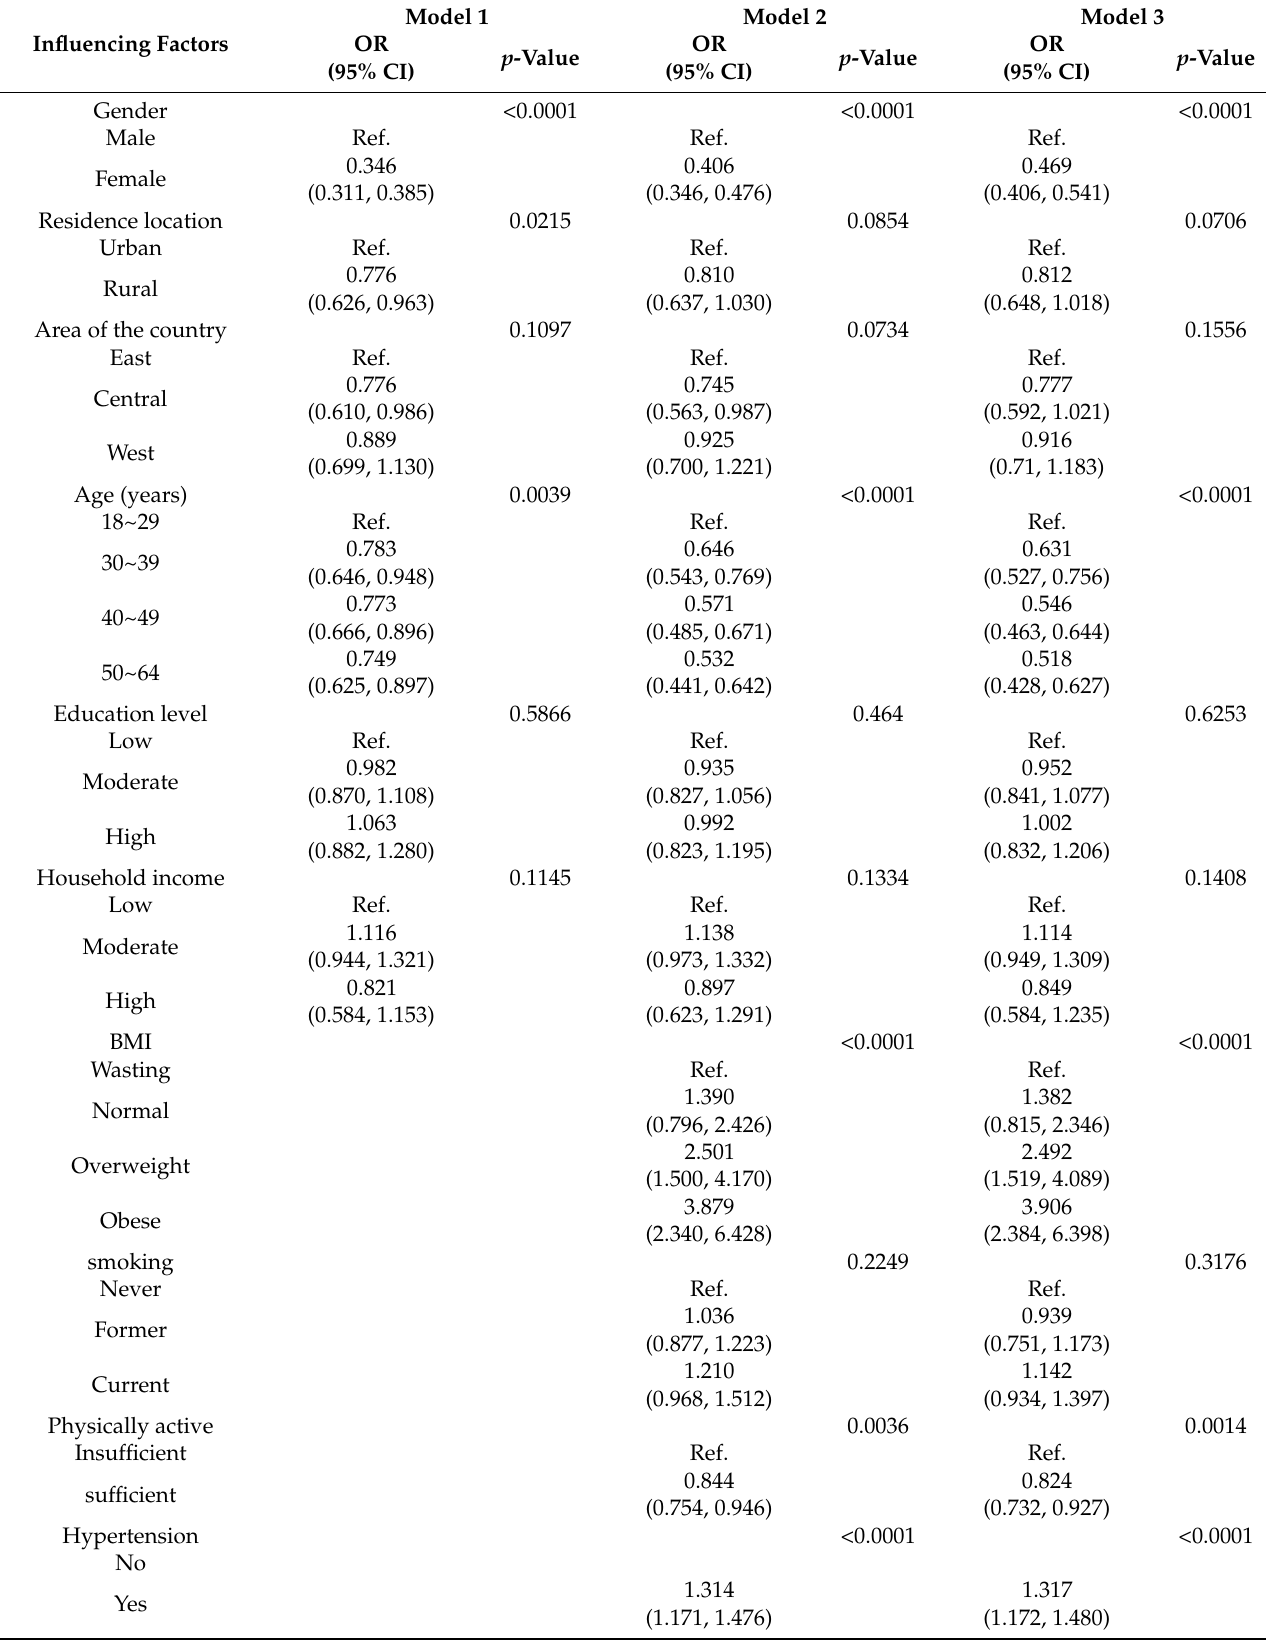
Table 3. Associations between risk factors and HUA in the